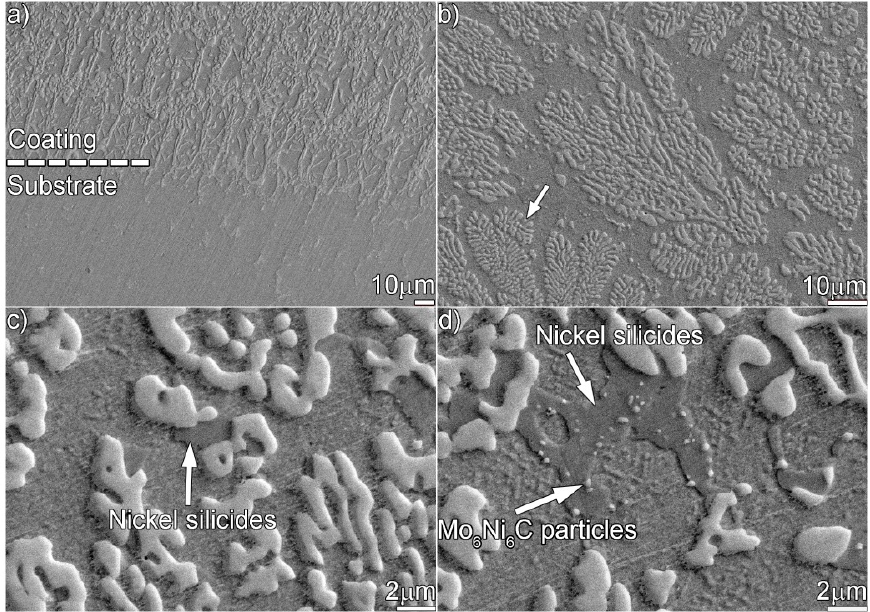
Materials 2019 , 12 , x FOR PEER REVIEW Figure 8. SEM secondary electron micrographs showing the microstructure in the coating aged for 480 h: ( a ) at the interface, ( b ) at the upper part, and ( c , d ) magnified morphology of the upper part.